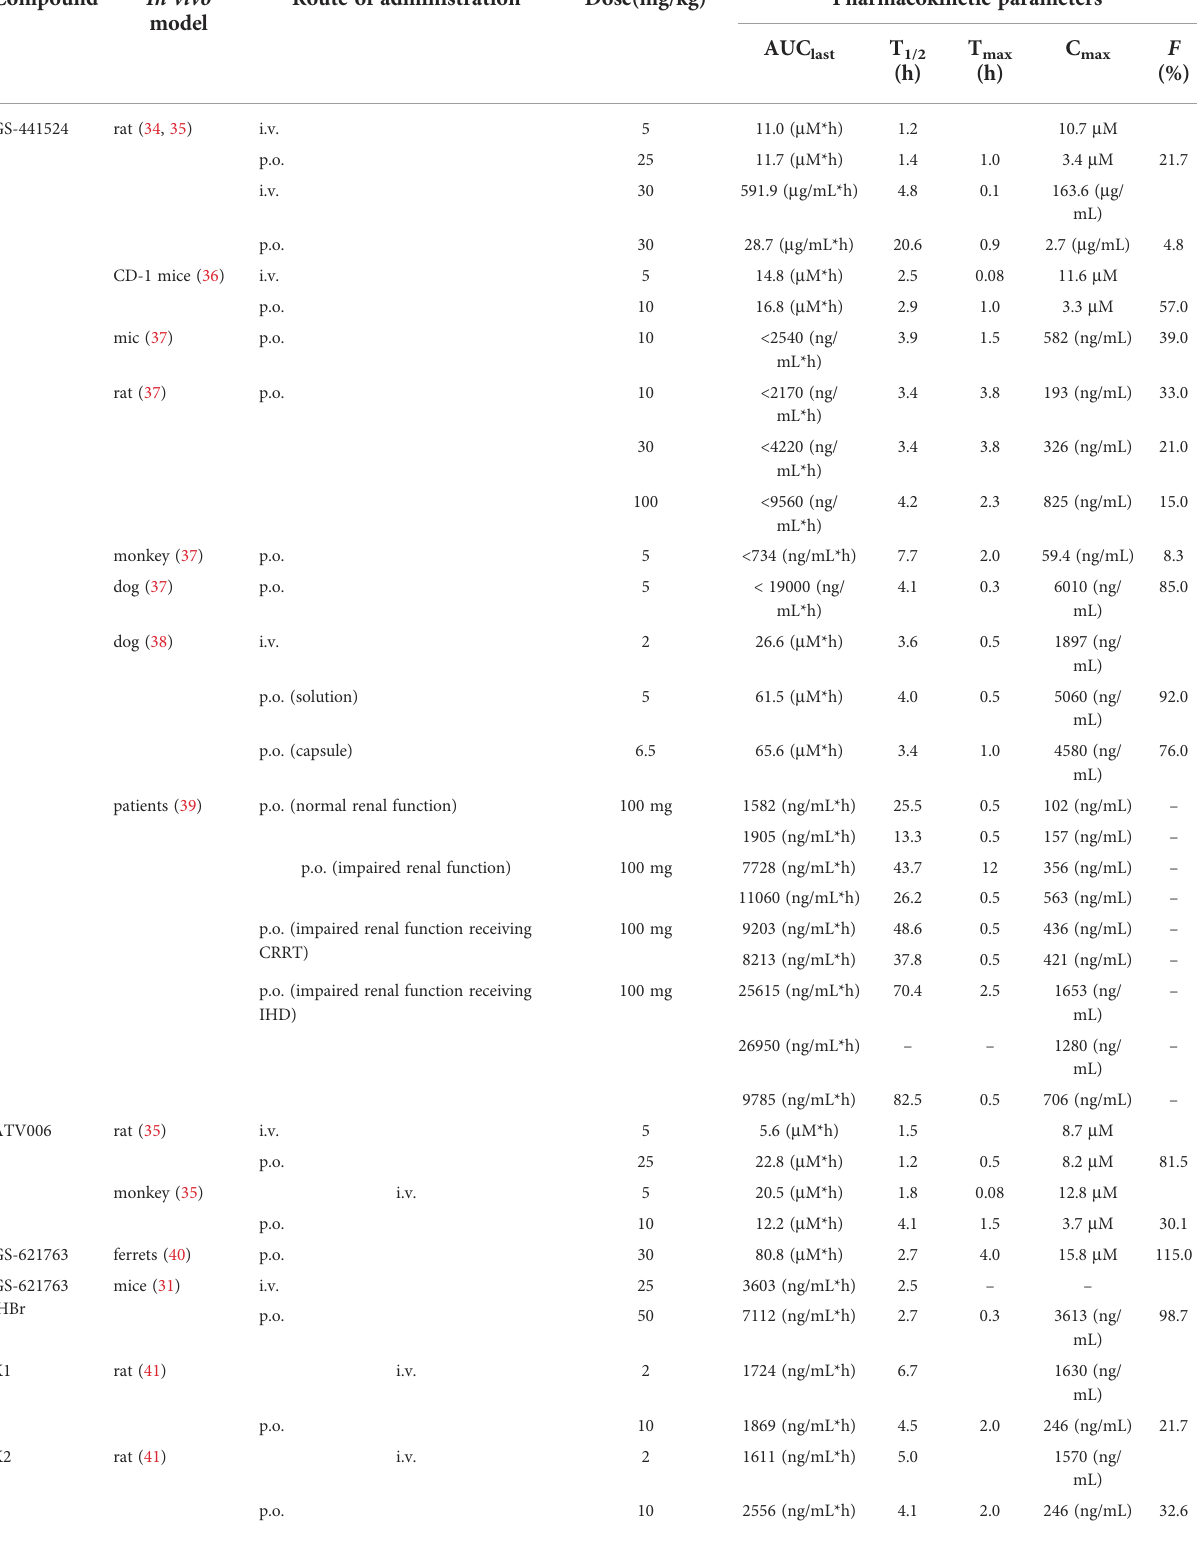
TABLE 1 Pharmacokinetic properties of GS-441524, VV116, and related compounds.